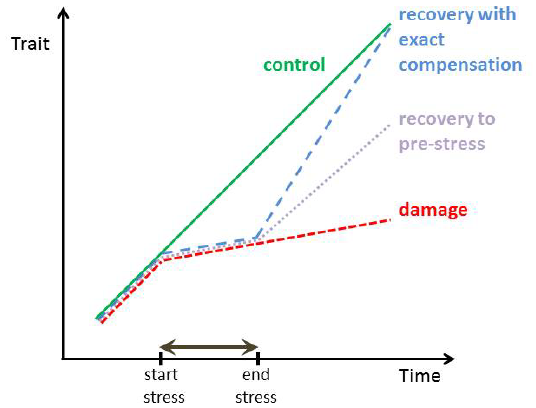
Figure 1. Schematic representation of plant responses to stress.